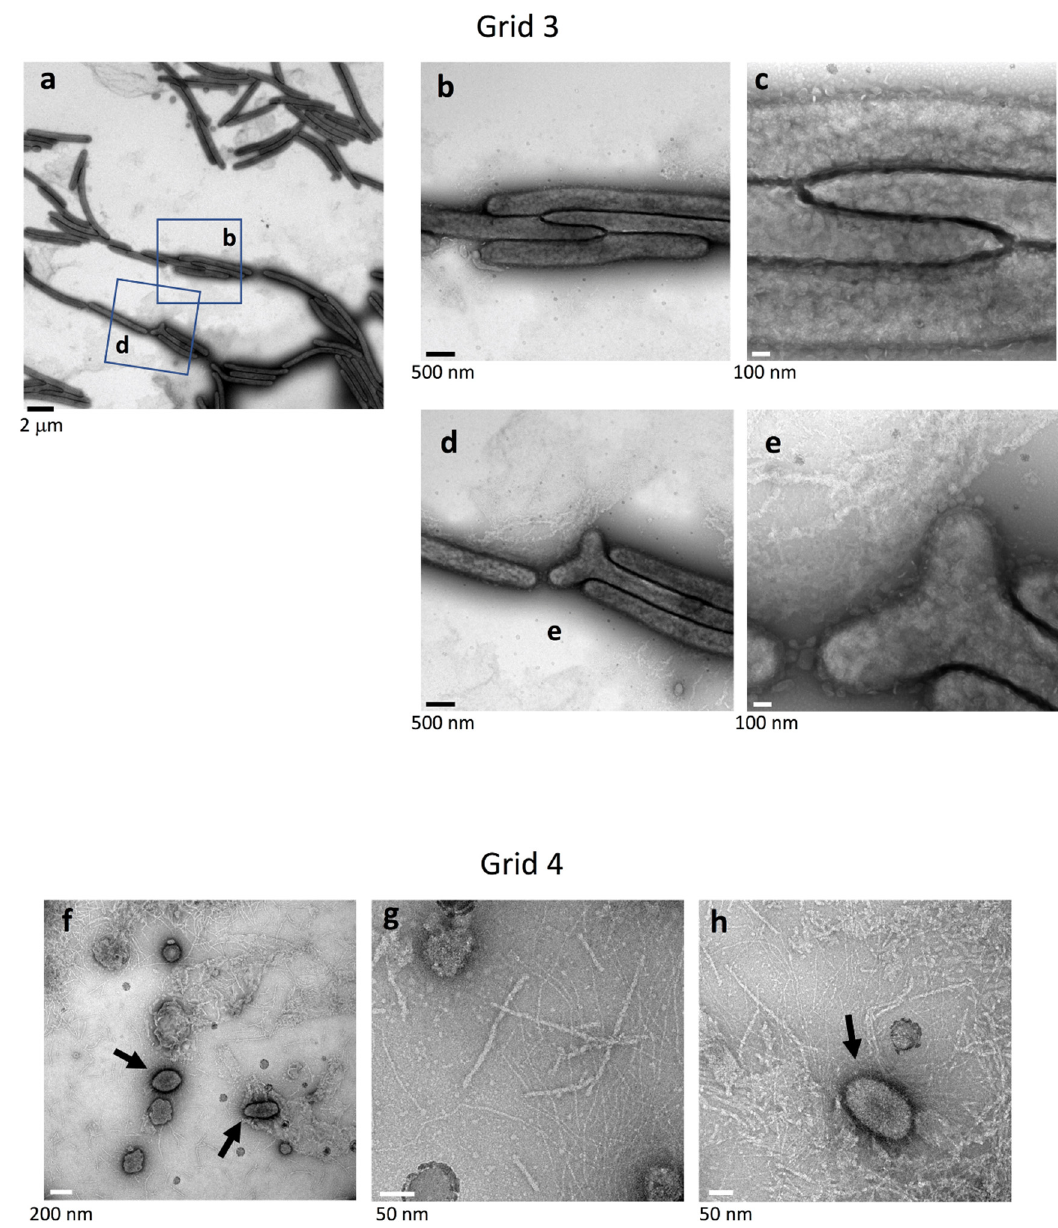
Figure 4. Top surfaces inside the edges of a WT colony body. Colony surfaces were sampled using the grid stamp method at Grid positions 3 and 4 (Figure 1b) and imaged by negative-stain TEM. ( a ) Low magnification image of the top surface slightly inside the edge of the yellow colony body (Grid position 3). Head-to-tail and/or side-to-side close contacts were formed between a large number of cells. ( b ) Higher magnification image (3.7×) of the area indicated in ( a ). ( c ) Higher magnification image (3×) of the central area in ( b ). ( d ) Higher magnification image (3.7×) of the area indicated in ( a ). ( e ) Higher magnification image (3×) of the central area in ( d ). ( f – h ) Top surfaces 2 mm inside the edge of the yellow colony body (Grid position 4). ( f ) Low magnification image. Almost no cells were imaged, but several large vesicles are prominent. ( g,h ) Higher magnification images. Most areas are occupied by large and small vesicles and extracellular filaments of various diameters. The large vesicles (150–250 nm in diameter) are indicated by arrows.